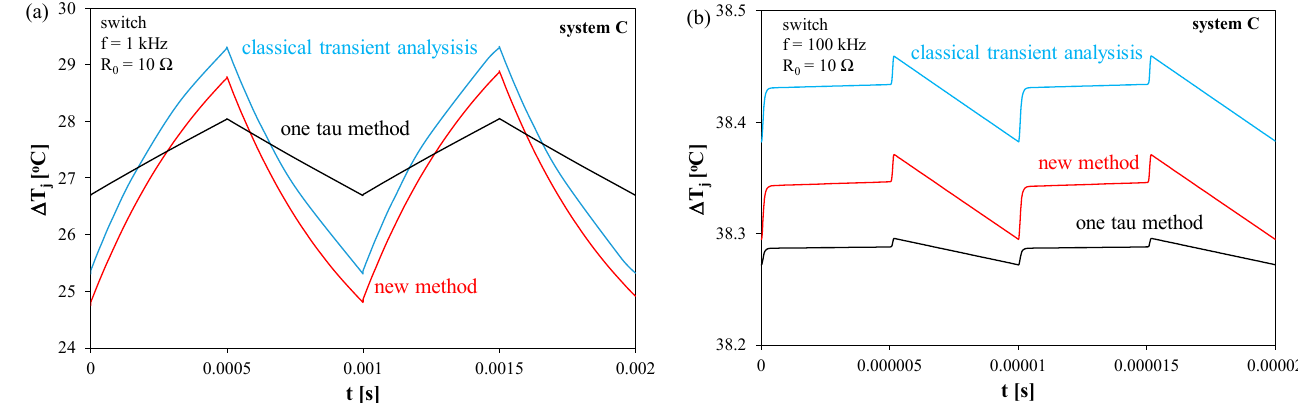
Figure 6. Computed waveforms of the junction temperature of the transistor operating as a switch with the cooling system C at frequency f equal to 1 kHz ( a ) and 100 kHz ( b ).